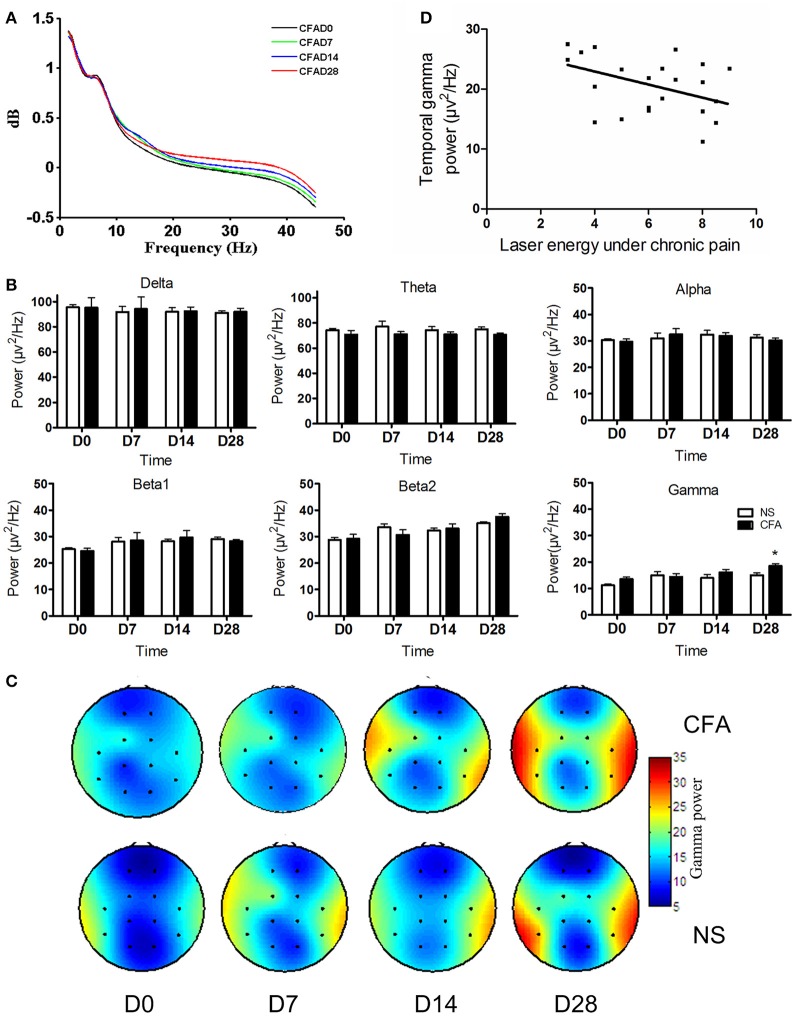
Enhanced gamma power in chronic pain. (A) Power spectrum during the development of chronic pain. (B) Grand average power (mean ± SEM) of each frequency band in CFA group and in NS control group at different days after CFA injection. Gamma band power was significantly higher at day 28 in the CFA chronic pain group compared with that in NS control group (*p < 0.05). (C) Gamma power over channels 3 and 10 was increased in the CFA chronic pain group (upper) compared with that in the NS group (below). (D) Negative correlation between gamma power over channels 3 and 10 and the hyperalgesia in chronic pain rats at D7, D14, and D28 after CFA injection (Pearson γ = −0.45, p < 0.05).